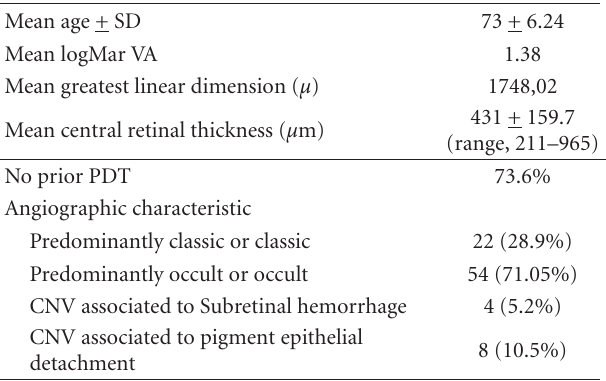
Table 1: Baseline features of patients with age-related macular degeneration and initial low visual